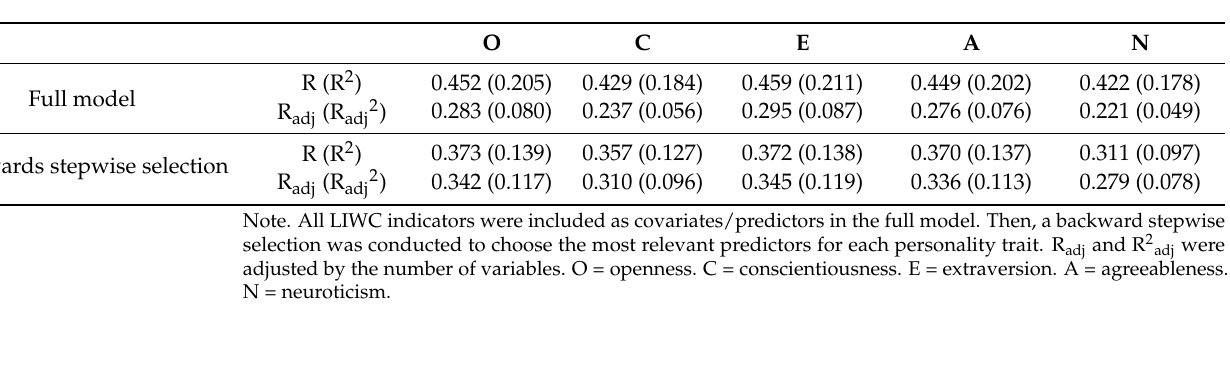
Table 1. Multiple linear regression model performances ( R and R 2 ) for each personality